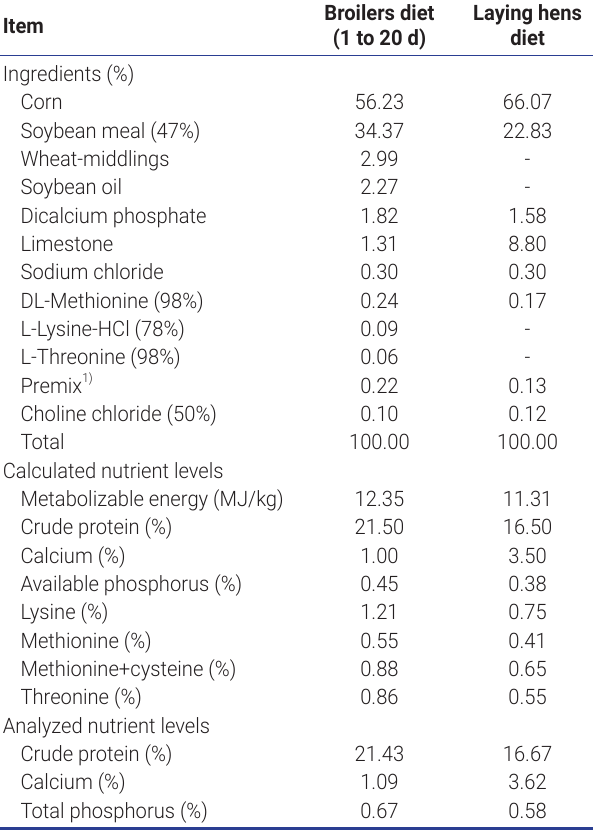
Table 2. Composition and nutrient levels of the basal diets, as-fed basis